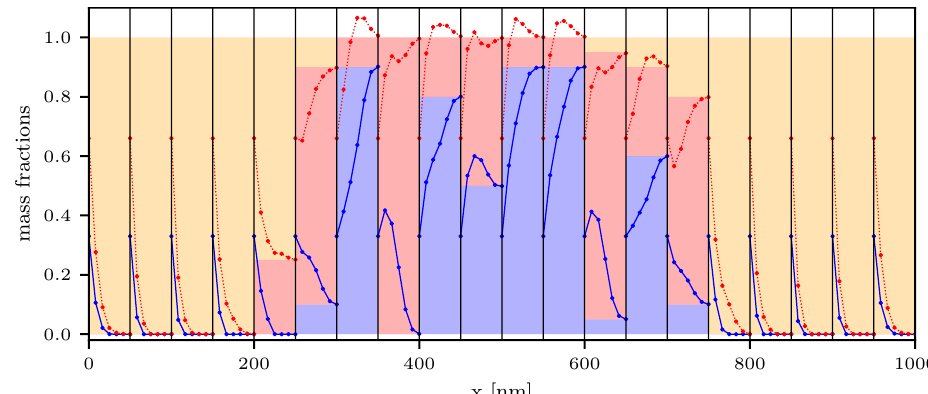
Figure 7. Reconstruction of a vertically layered material. Electron beams bombard the sample from above with 17 keV centered at each of the 50 nm layers, whose interfaces are indicated by vertical black lines. The background color shows the hidden truth mass fraction of each layer (blue: chromium, red: nickel, orange: iron). The lines (blue solid: chromium, red dotted: nickel) in each layer show the Levenberg–Marquardt steps from initial ( left ) to sixth iteration ( right ). These two parameters are sufficient to describe all three mass fractions (see Section 2). No additional constraint was applied during the optimization, hence the nonphysical behavior c Cr + c Ni > 1 during the optimization. Nevertheless, all parameters are reconstructed